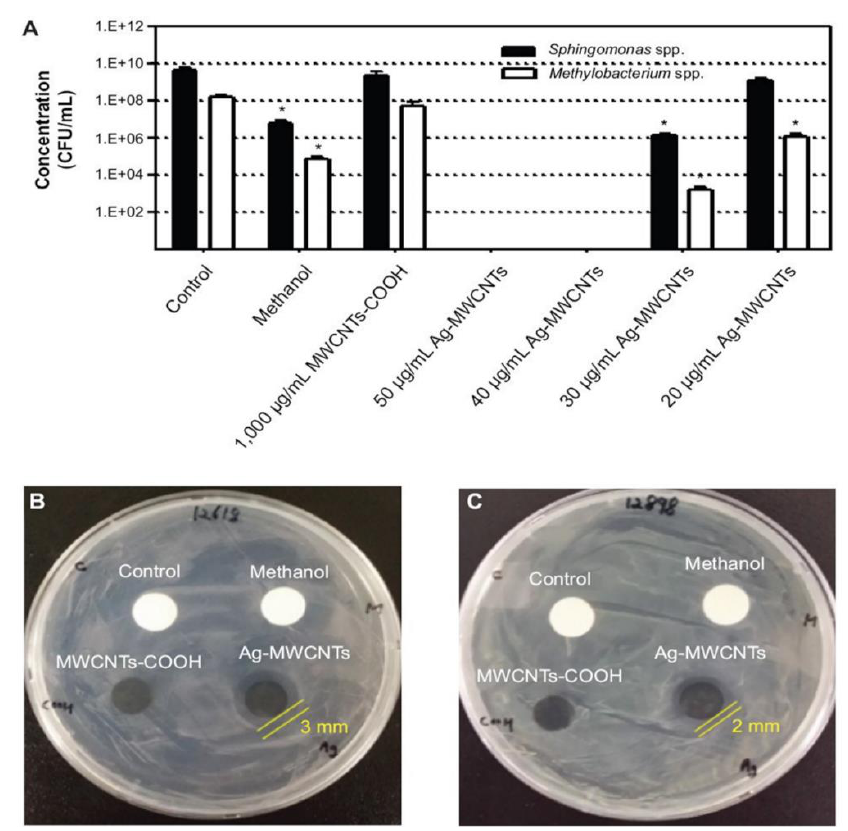
Figure 1. ( A ) Antibacterial activity of acid-treated multiwalled carbon nanotubes (MWCNTs-COOH) and different concentrations of Ag-MWCNTs against Sphingomonas spp. and Methylobacterium spp. * p < 0.05, one-tailed Mann–Whitney U-test. Data are representative of three experiments. ( B ) Evaluation of the inhibition zone of different samples against Sphingomonas spp. ( C ) Inhibition zone against Methylobacterium spp. Reproduced from Ref. [38].